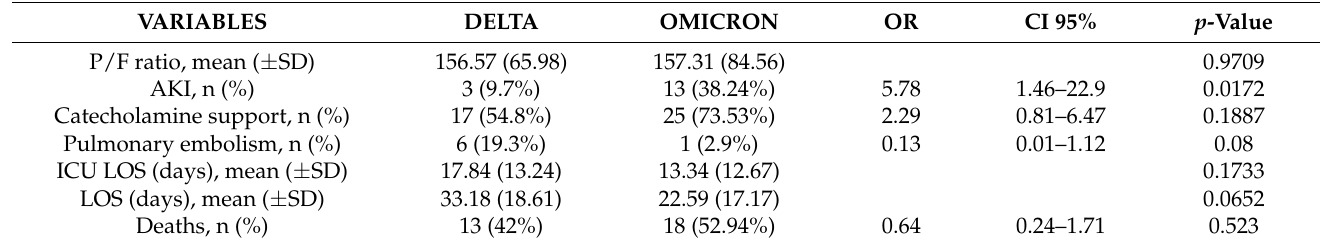
Table 2. ICU clinical parameters on admission and outcome of patients belonging to Delta and Omicron groups. Values are means (+S.D.) or number (%). OR: odds ratio; CI: confidence